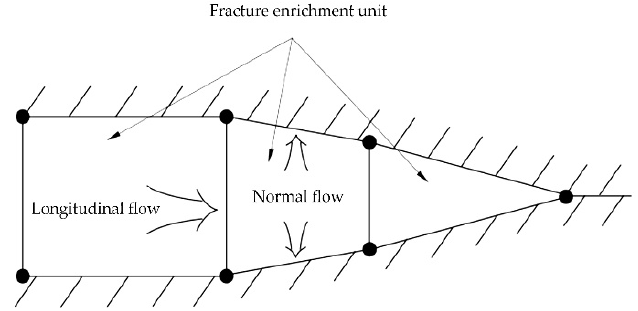
Figure 2. Flow pattern of fluid in fracture.